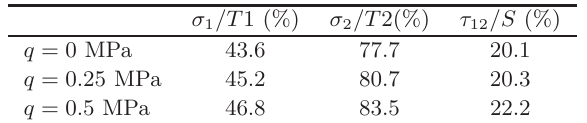
Table 3. Deterministic calculations : stress ratios for carbon- epoxy ( F = 200 kN).